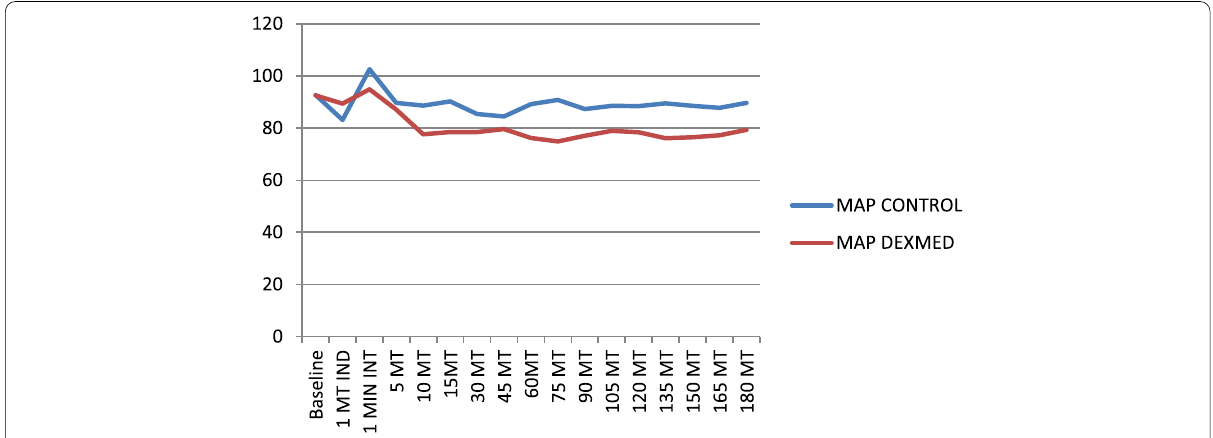
Fig. 7 Mean arterial pressure response with the control and dexmeditomidine